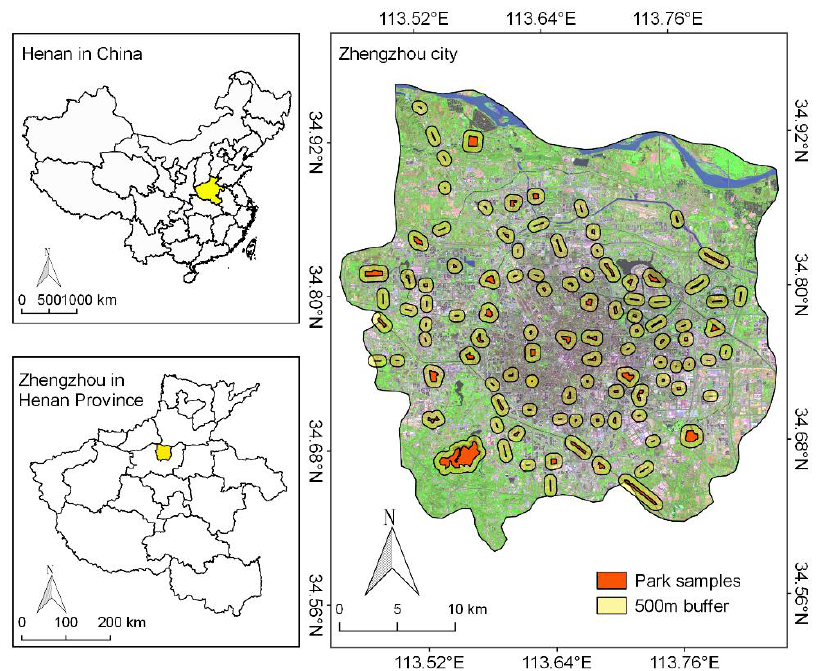
Figure 1. Location of the study area Zhengzhou, Henan province in China and 123 park samples in Zhengzhou.